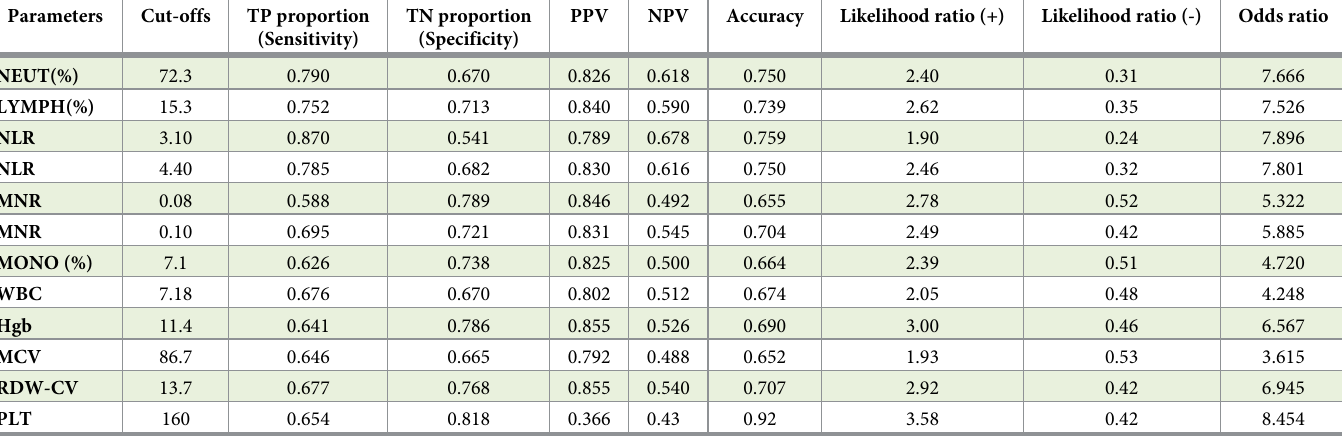
Table 4. Prognostic evaluation of the best parameters to indicate severity of disease.